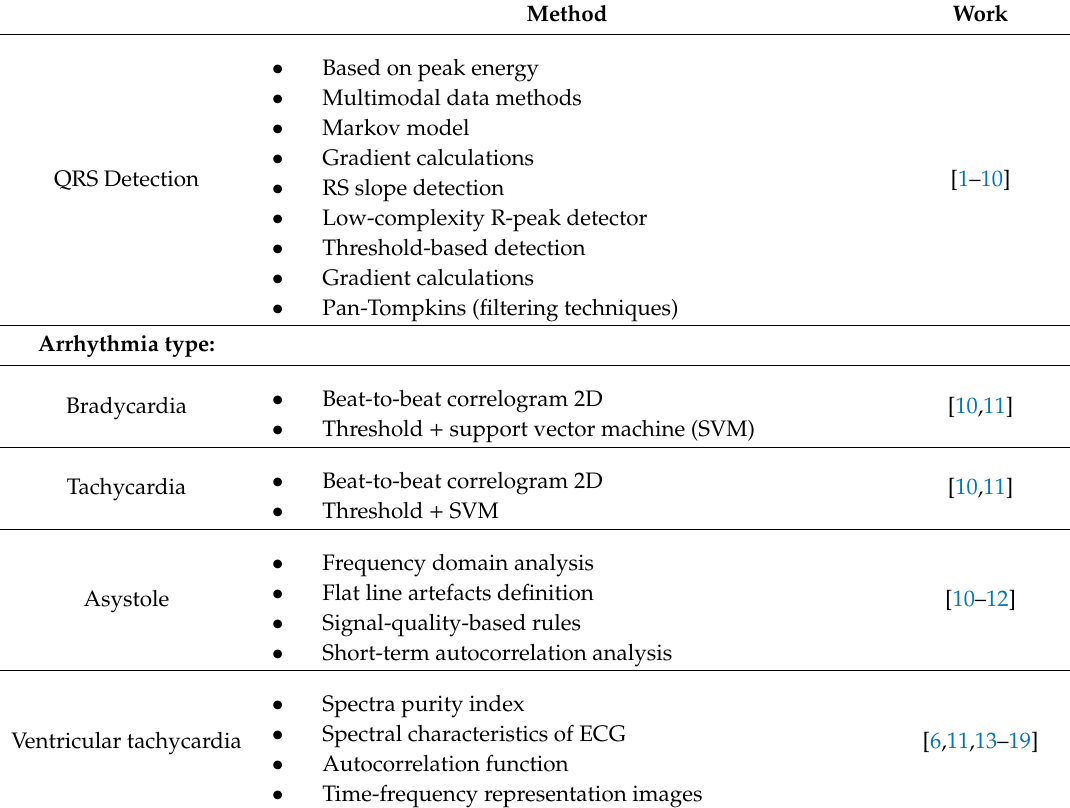
Table 1. Methods of detecting